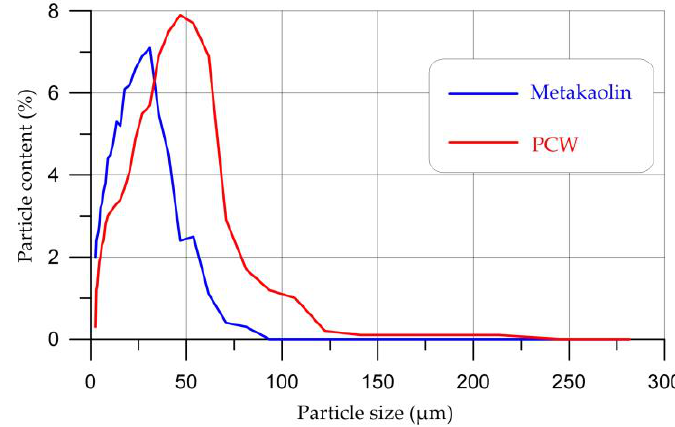
Figure 6. Particle distribution curves of metakaolin and PCW.